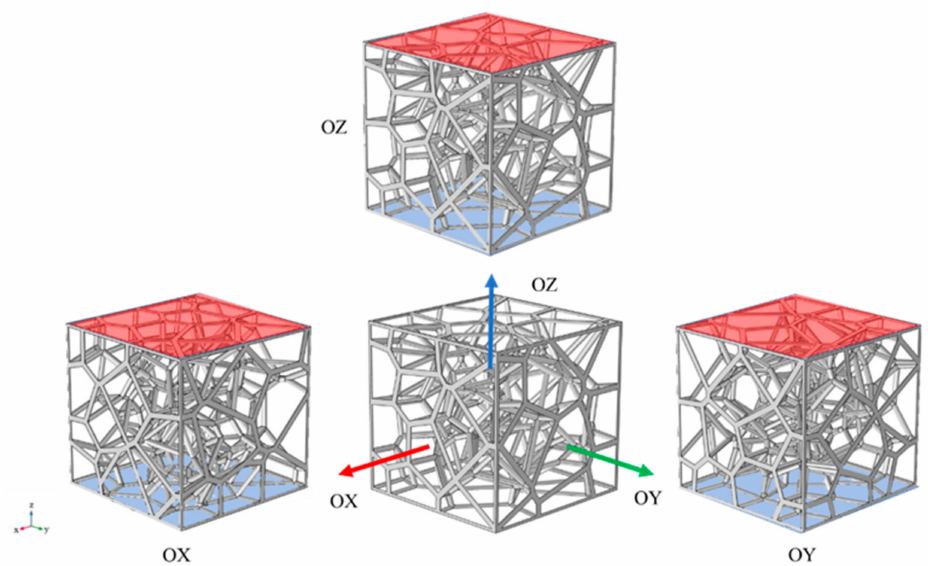
Figure 5. RV50 structure with a porosity of 94.82% in the OX, OY, and OZ orientation, the upper and lower surfaces of the models were applied to constant thermal loads of 375.15 K and 293.15 K